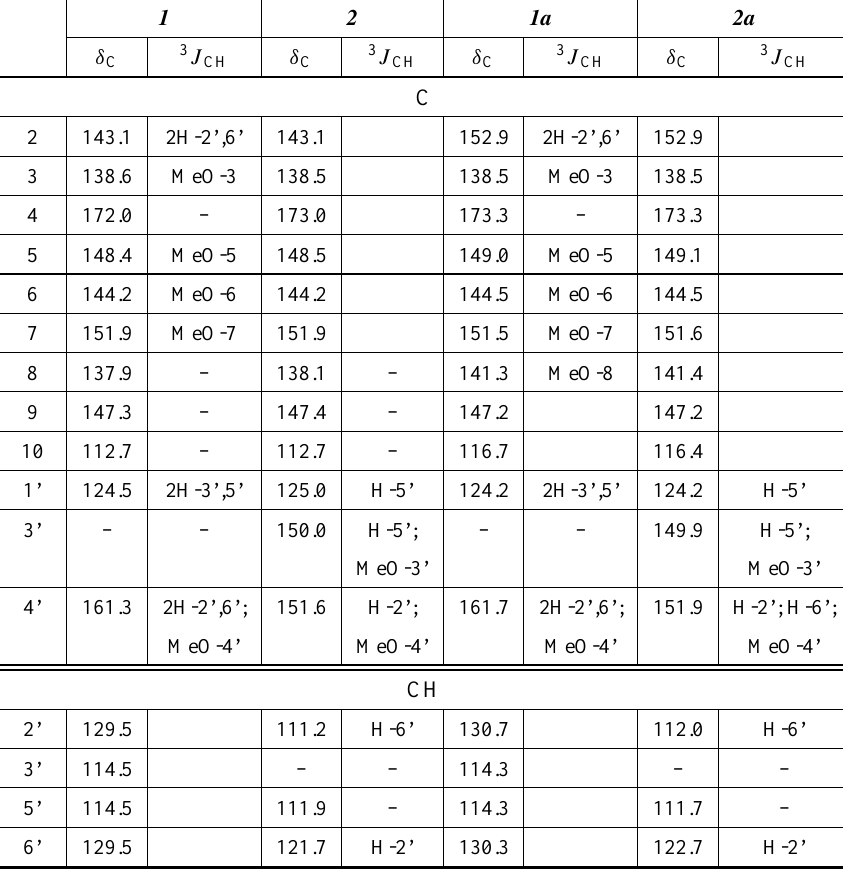
Long-range couplings of hydrogen and carbon atoms observed in the HMBC ( n J CH , n = 2 and 3) spectra of flavonols 1 and 2 and their 8-O-methyl ether derivatives ( 1a and 2a ), in benzene- d 6 as solvents. Residual C 6 D 6 was used as internal reference ( δ H 7.16 and δ C 128.00, respectively). Chemical shifts ( δ , in